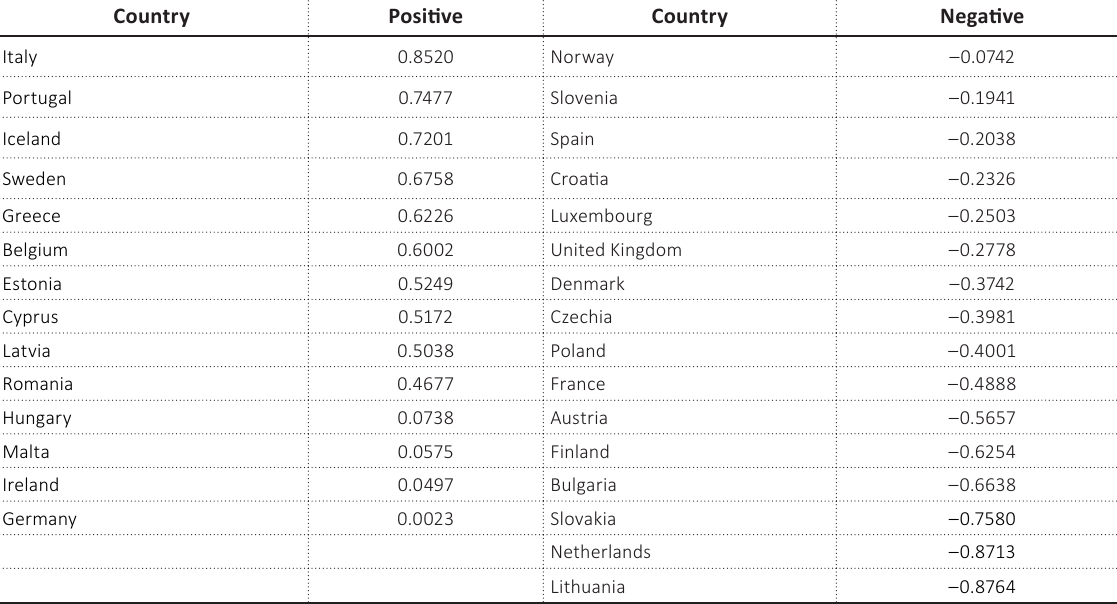
Table 3. Correlation between TFEE and TI bi-annually,